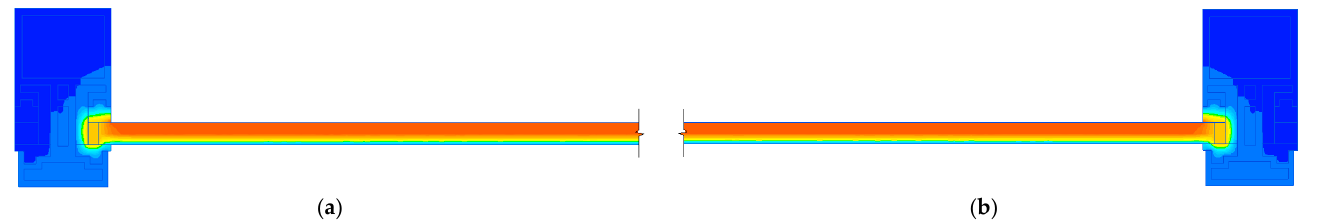
Figure 9. Visualization of the heating of the ( a ) left side and ( b ) right side of the glazing structure of samples No. 2.1–No. 2.3.